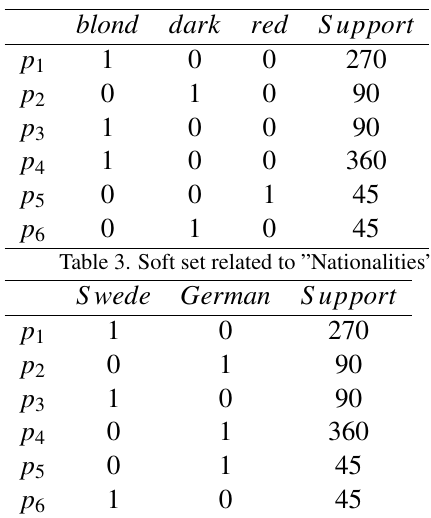
Table 2. Soft set related to ”Hair”